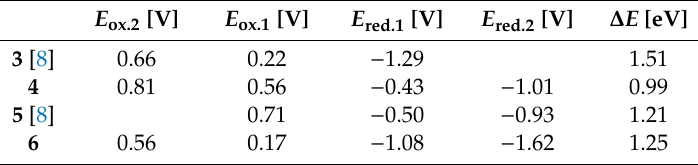
Table 1. Oxidation potentials ( E ox. ), reduction potentials ( E red. ) vs Fc / Fc + in V, and electrochemical HOMO–LUMO gaps ( ∆ E ) for 3 to 6 [a]